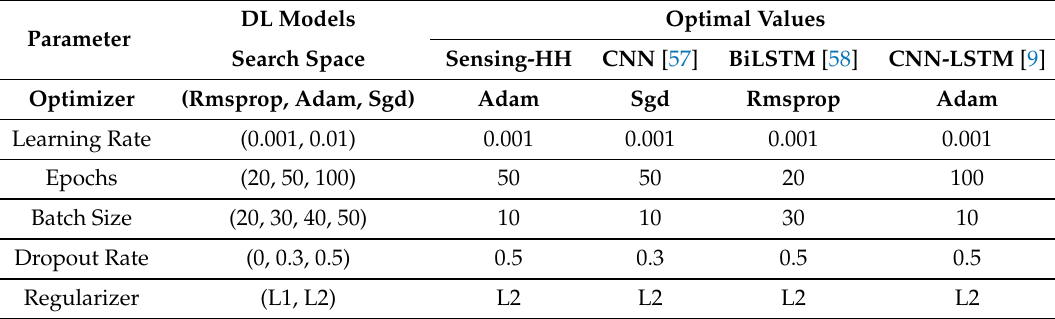
Table 3. Setting of